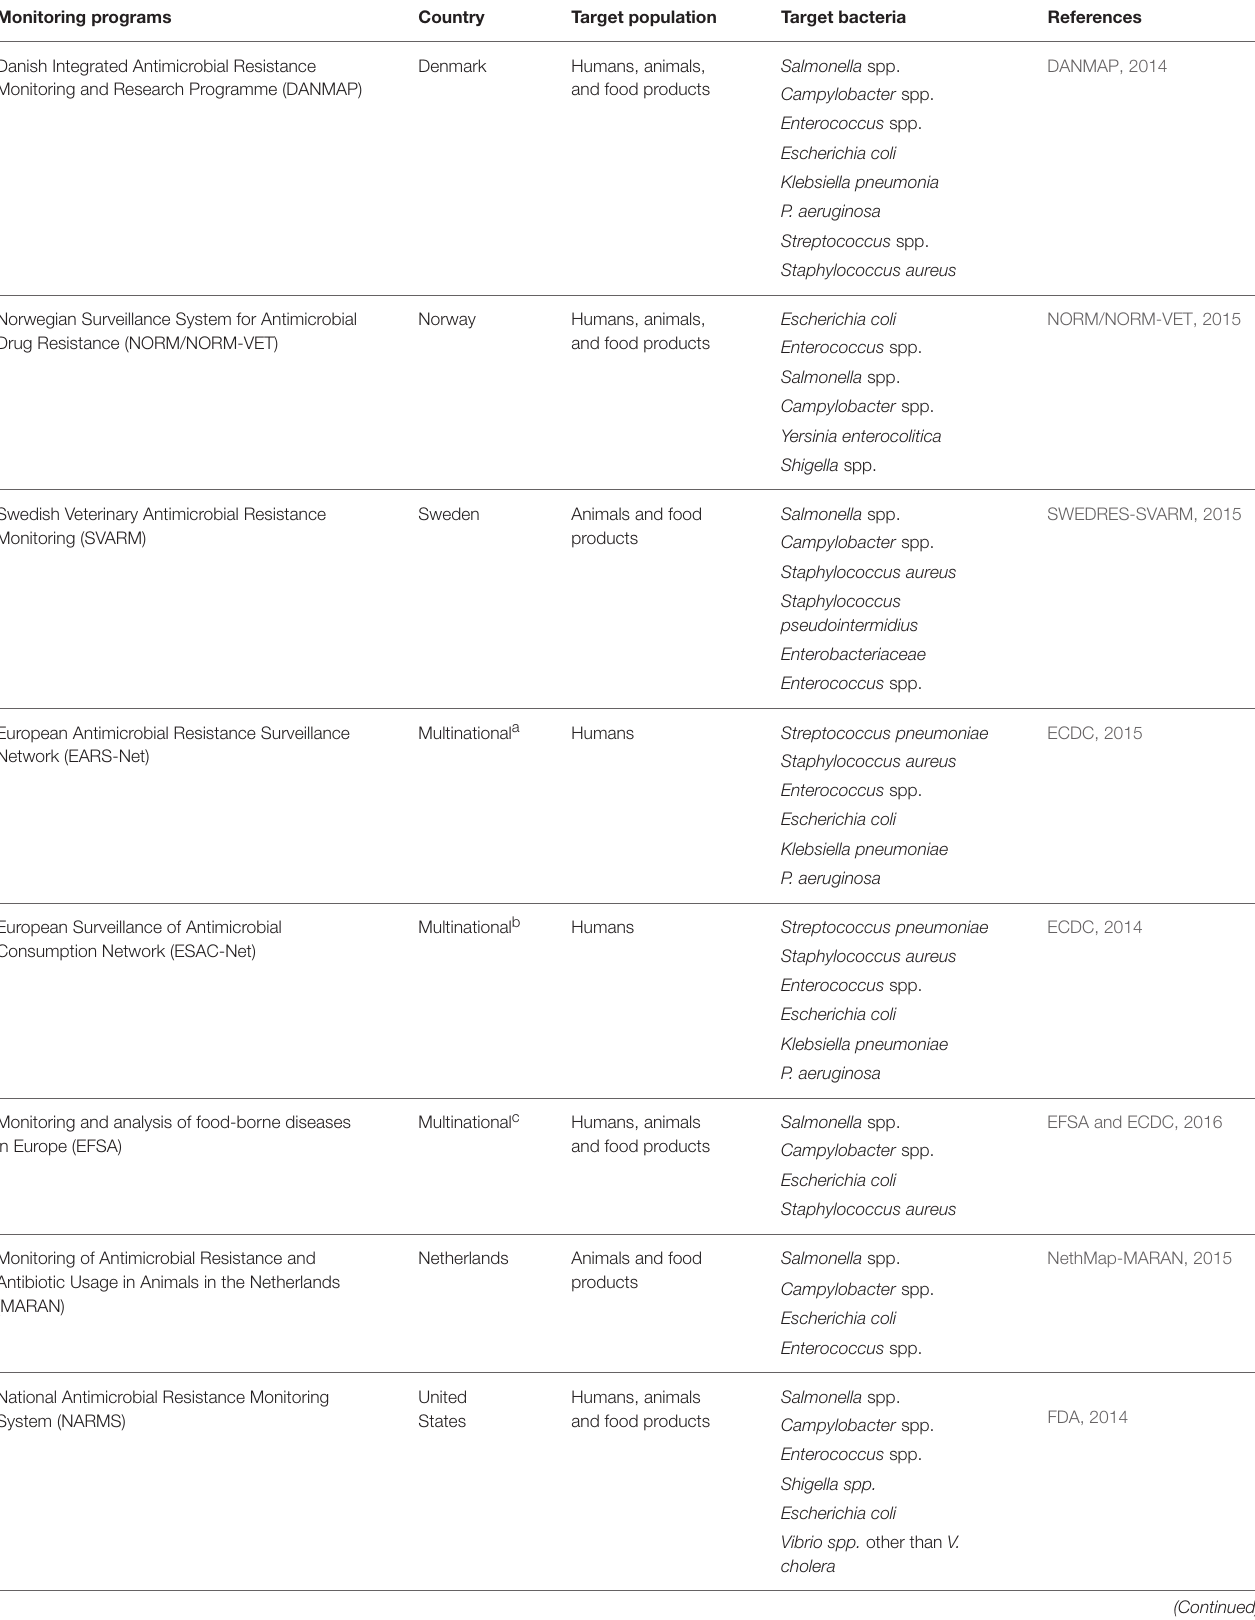
TABLE 1 | Examples of programs for surveillance and containment of antibiotic